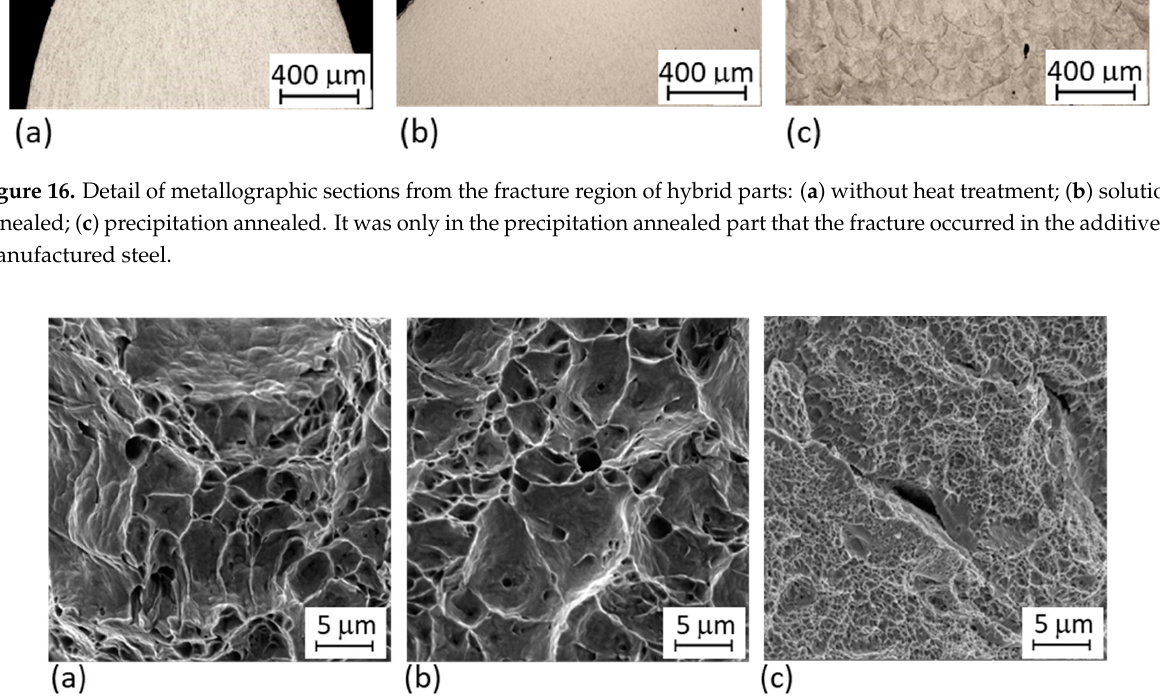
Figure 17. Fracture surfaces of hybrid parts: ( a ) without heat treatment; ( b ) solution annealed; ( c ) precipitation annealed.